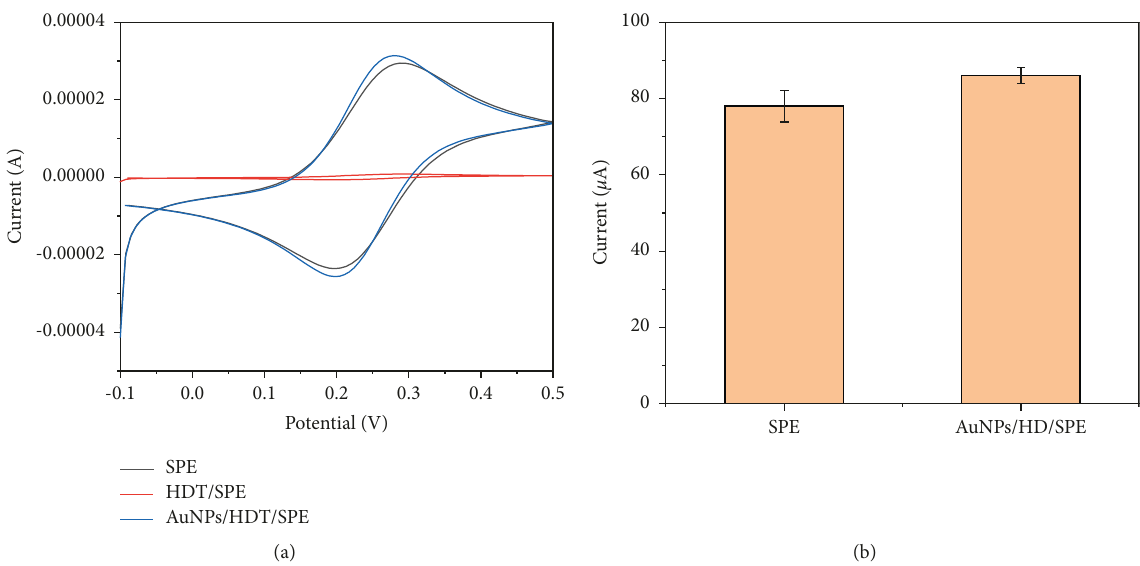
Figure 2: (a) Cyclic voltammetry of bare SPE, HDT/SPE, and AuNPs/HDT/SPE at [Fe(CN)6] 4-/3- . (b) The mean and standard variance of redox current recorded by cyclic voltammetry scanning in [Fe(CN)6] 4-/3- at six electrodes before and after AuNPs modification (0.1M